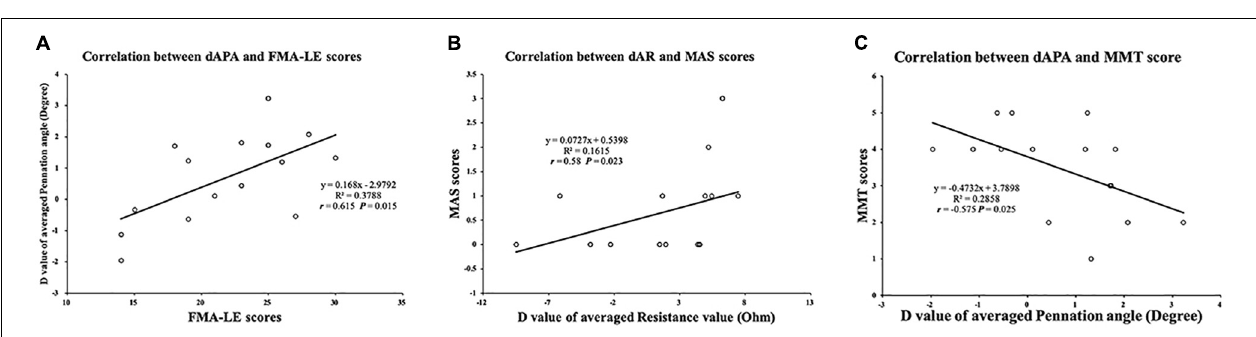
FIGURE 6 | Correlation between muscle intrinsic properties and clinical scales. (A) Significant correlation between FMA-LE score and dAPA value. (B) Significant correlation between MAS score and dAR value. (C) Significant correlation between MMT score and dAPA value. FMA-LE, Fugl–Meyer assessment of lower extremity; MAS, modified ashworth scale; MMT, manual muscle test; dAPA, difference value of average pennation angle parameter; dAR, difference value of average resistance parameter.